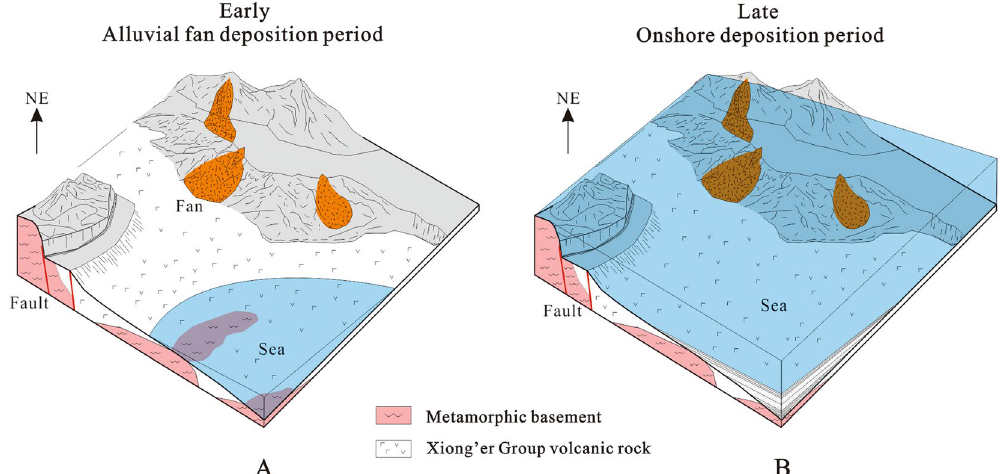
Figure 8. Sedimentary model of the Bingmagou Formation on the southern margin of the North China Craton. ( A ) Development period of the Bingmagou Formation alluvial fan. ( B ) Development period of the Bingmagou Formation coastal facies (Fig. 8 was created and drawn with CorelDRAW X7 by